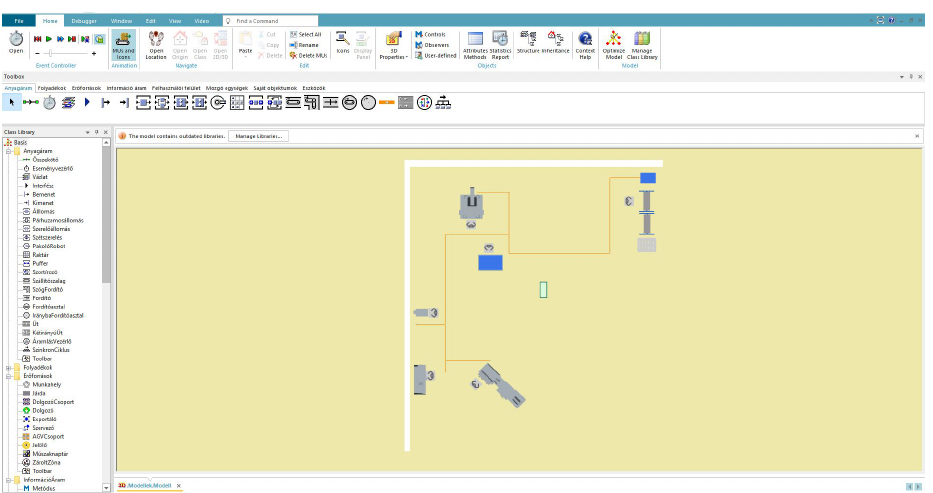
Figure 10. The plant simulation model of the laboratory and the user